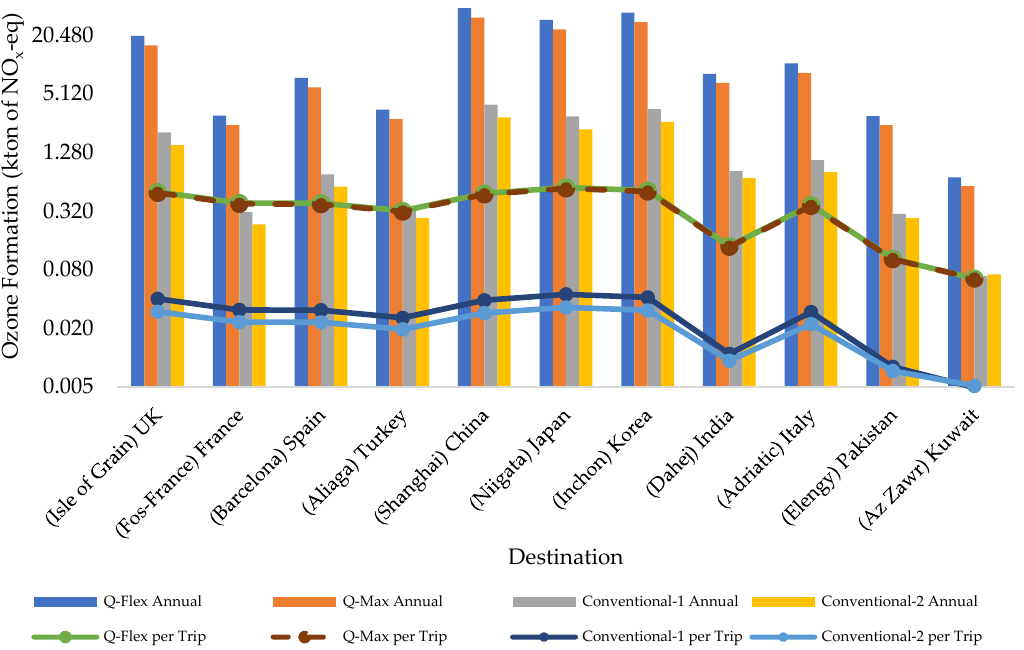
Figure 5. NO x -eq emission results for the roundtrip and annual.